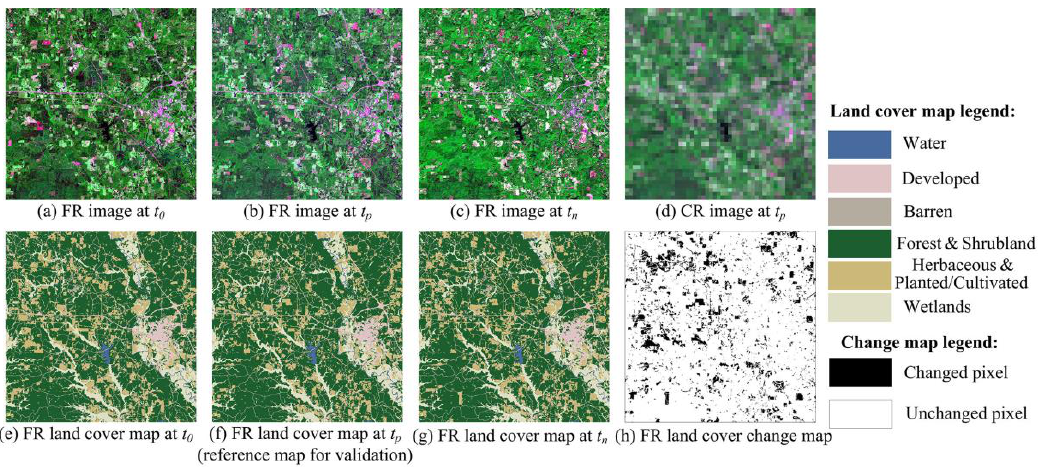
Figure 3. The fine spatial resolution (FR) images, coarse spatial resolution (CR) image, FR land cover maps and FR land cover change map used in the National Land Cover Database (NLCD) experiment. The scale factor s was 16. ( a ) FR image at t 0 from Landsat image acquired on 7 October 2011; ( b ) FR image at t p from Landsat image acquired on 13 November 2013; ( c ) FR image at t n from Landsat image acquired on 5 November 2016; ( d ) CR image at t p resampled from ( b ); ( e ) FR land cover map at t 0 ; ( f ) FR land cover map at t p (reference land cover map); ( g ) FR image at t n ; ( h ) FR land cover change map that was produced by comparing ( e – g ).